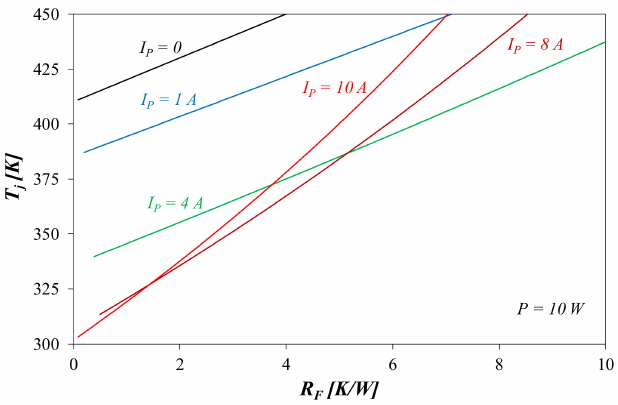
Figure 11. Device junction temperature versus the fin thermal resistance at selected values of current I P